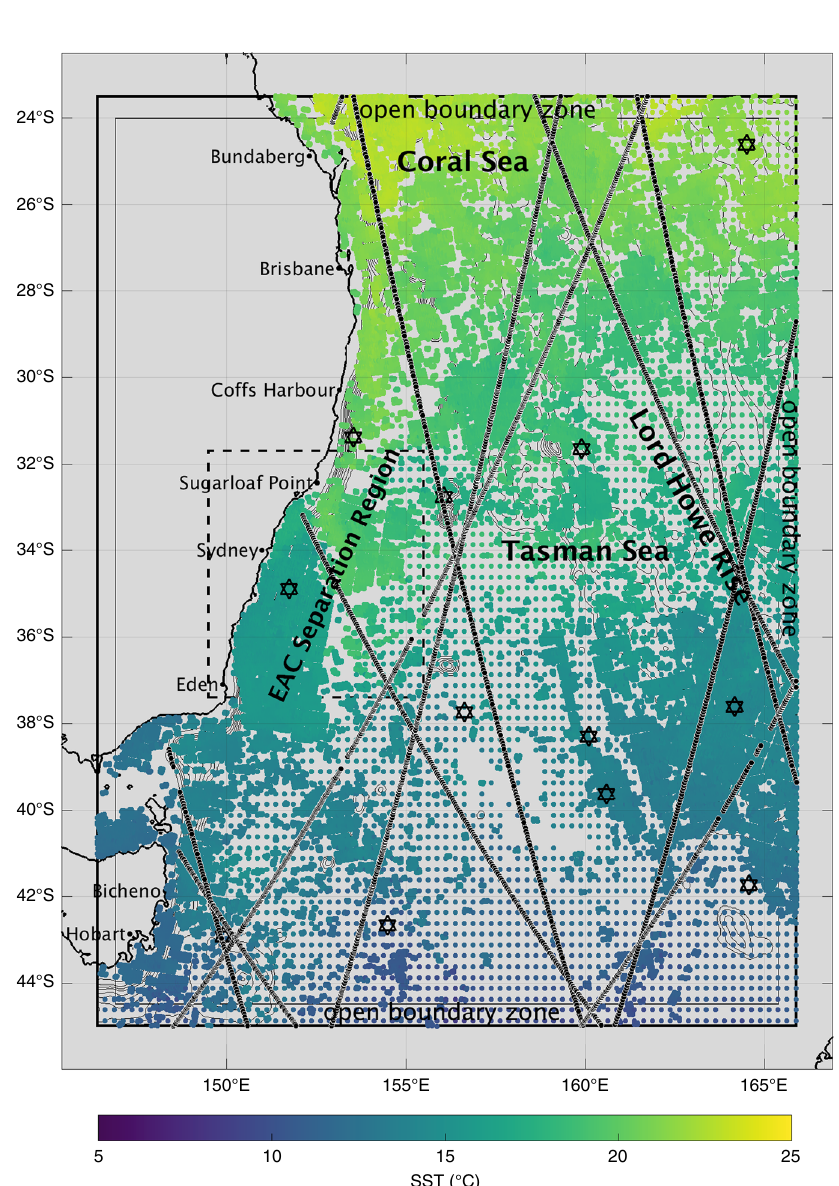
Fig. 4 The study region. Also shown are areas delimited as open boundary zones, the East Australian Current (EAC) separation region and typical super- observation coverage for a single 3-day cycle for 14 – 16 September 2008. The coloured circles are sea surface temperature (SST), the black lines correspond to along track altimeter observations and the black stars are the positions of Argo pro fi